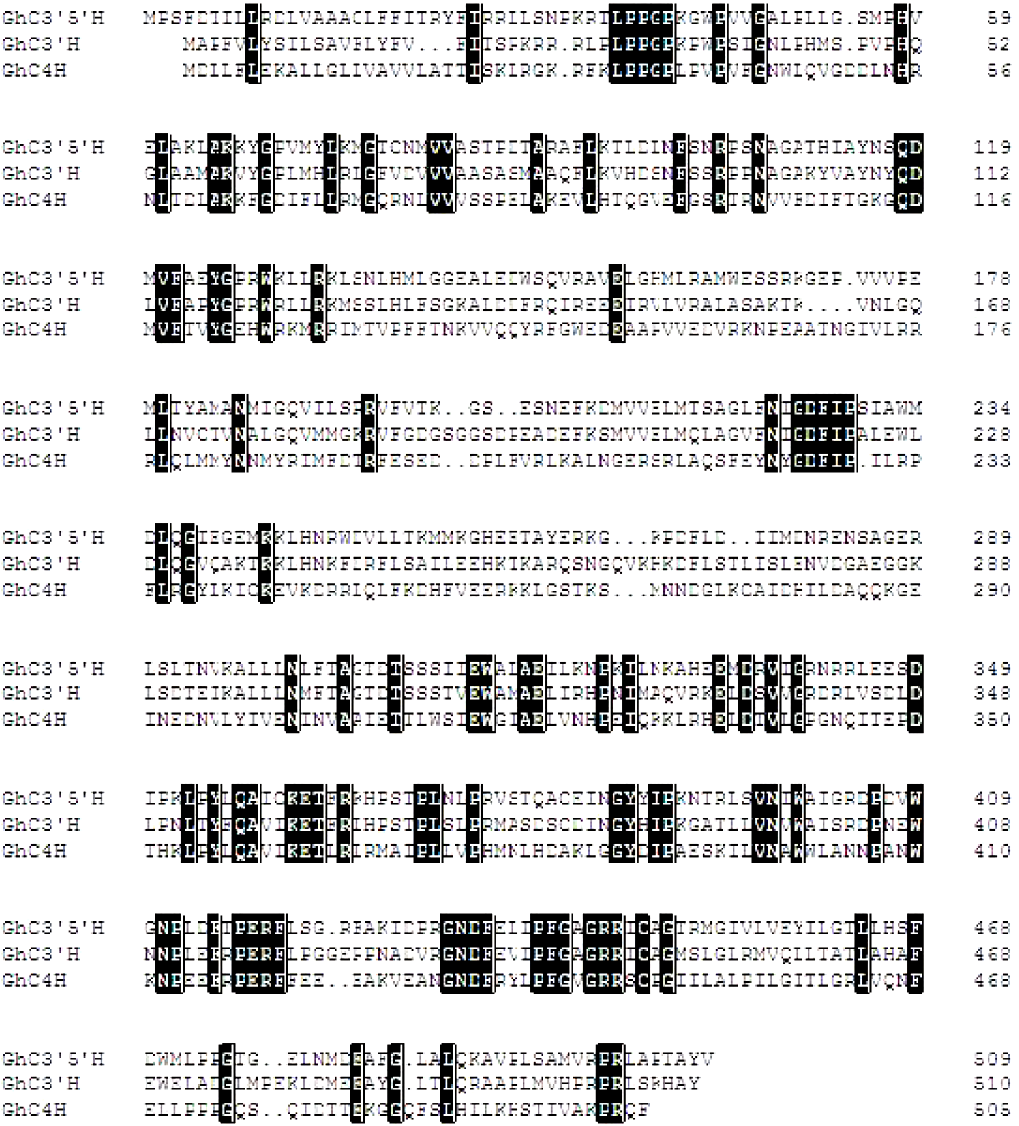
Figure 4. Multiple alignment of deduced amino acid sequences of Cinnamate-4-hydroxylase (C4H), flavanone-3-hydroxylase (F3 9 H), flavonoid-3’5’-hydroxylase (F3 9 5 9 H) from the brown cotton fiber.